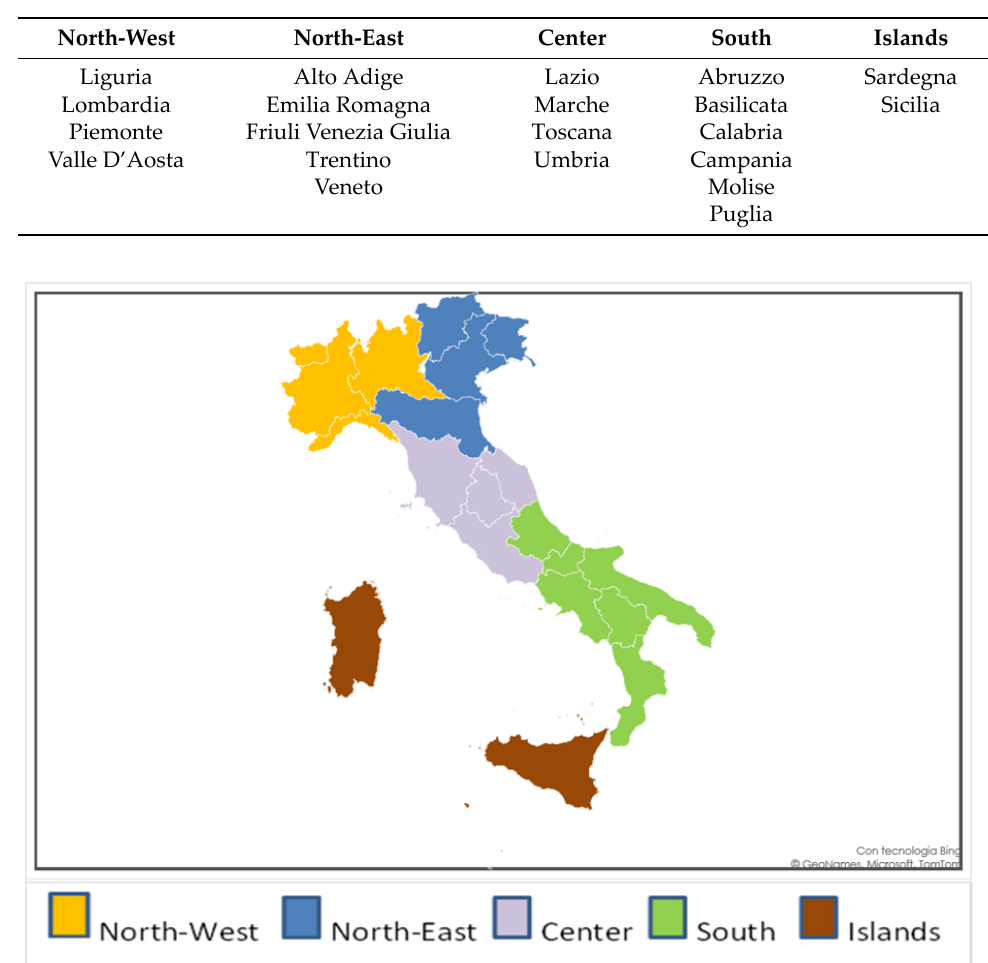
Table 1. Composition of Italian district by regions.